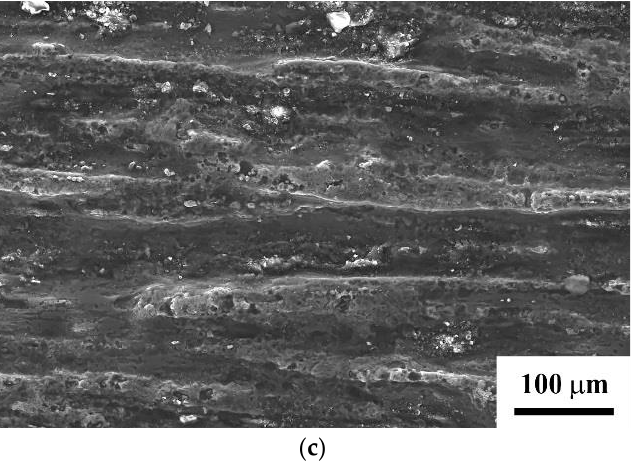
Figure 6. Structure of specimens of Mg-Al-Zn alloy in the initial state ( a ), reduction – ECAP ( b ), reduction – ECAP+UST, ( c ) after corrosion. On the image b, arrows indicate the places of corrosion development.